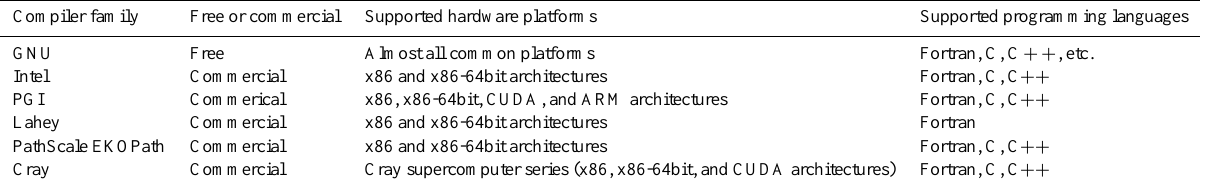
Table 1. Compiler families used for Earth system modeling. They are from the supported compiler lists of several ESMs.